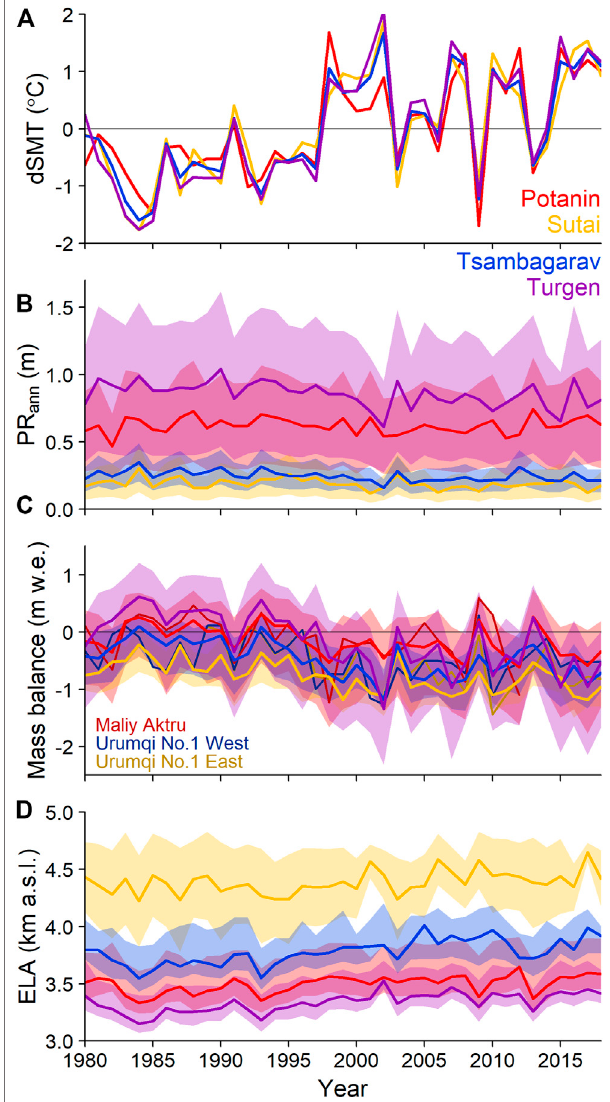
FIGURE 8 | Time series of the (A) summer mean temperature anomaly (dSMT) relative to the long-term mean, (B) annual precipitation (PR ann ), (C) calculatedglacier-widemassbalance,and (D) equilibriumlinealtitude(ELA)of Potanin (red), Sutai (yellow), Tsambagarav (blue) and Turgen (purple) glaciers.Theshadedregionsdenotetherangesofthecalculatedvaluesforthe tested precipitation parameters. In-situ observational mass balances of Maliy Aktru in Russian Altai (dark red line) and of Urumqi No. 1 Glacier in Tienshan (West and East branches, dark blue and dark yellow) are also depicted in (C) .